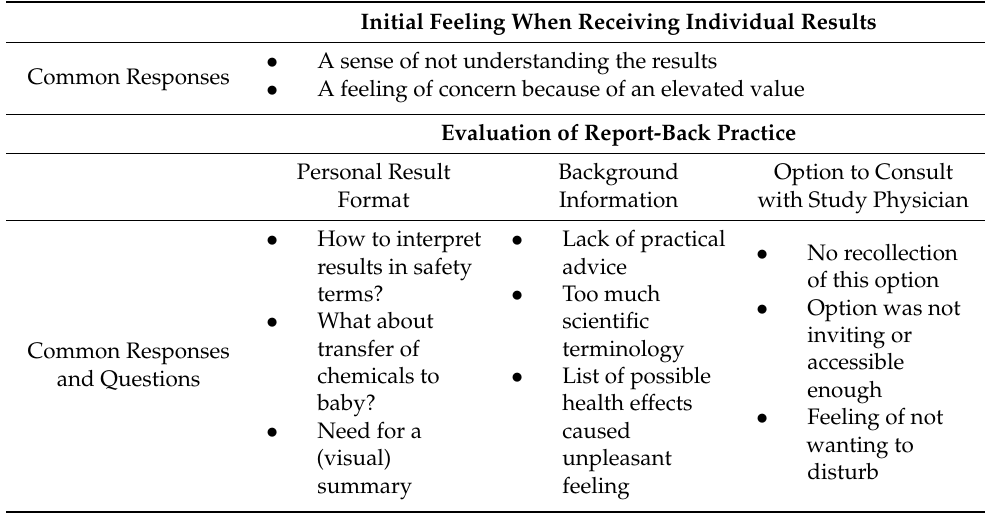
Table 5. Common responses to the topic of receiving results and evaluation of report-back